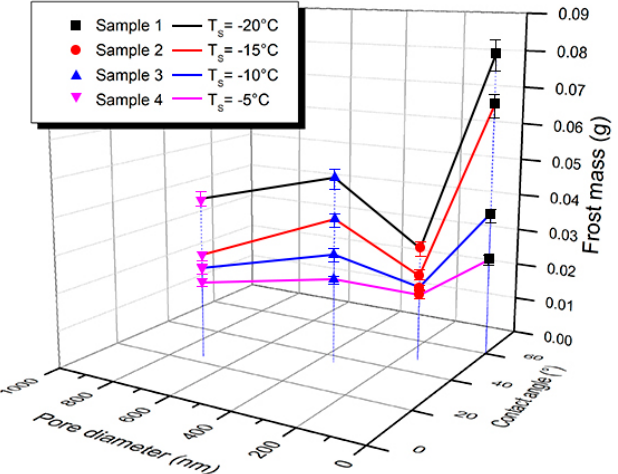
Figure 8. The relationship between the frost mass, contact angle, and pore diameter under different surface temperatures.